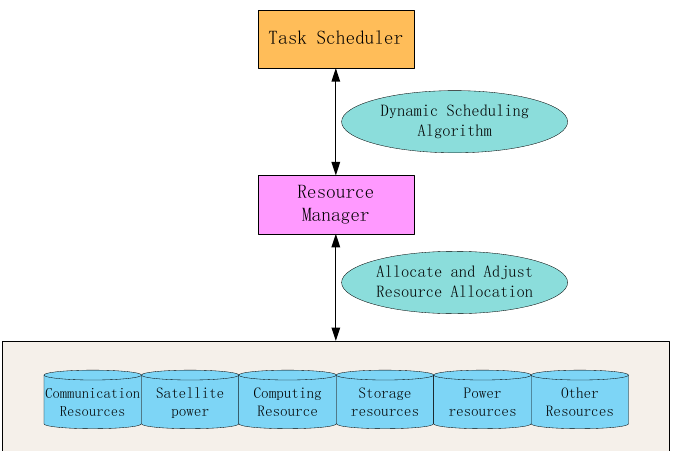
Figure 1. Overall framework